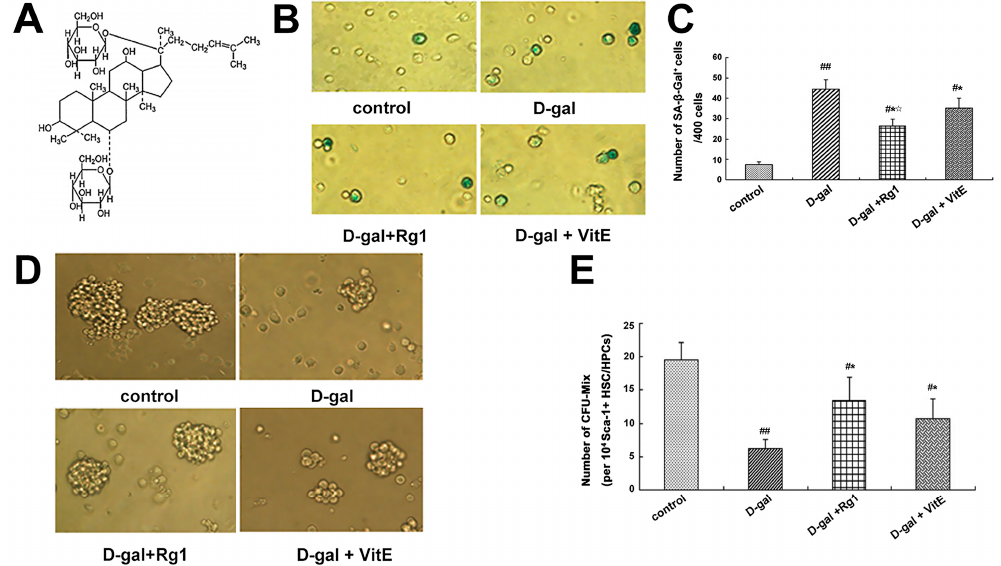
Figure 1. Effects of ginsenoside Rg1 on SA- β -Gal staining and CFU-Mix formation of Sca-1 + HSC/HPCs in a mouse model of D -gal-induced aging. ( A ) The chemical structure of ginsenoside-Rg1; ( B ) SA- β -Gal staining was performed after Sca-1 + HSC/HPCs were collected in different mouse model groups (×400). The aged cells were enlarged in shape and stained blue-green in the cytoplasm; ( C ) Quantification of SA- β -Gal–positive cells is shown. The number of SA- β -Gal–positive cells was decreased in the D -gal + Rg1 and D -gal + VitE groups compared to the D -gal model group. The total number of SA- β -Gal–positive cells was counted among 400 random cells; ( D ) CFU-Mix culture of Sca-1 + HSC/HPCs in different mouse model groups is shown (×400). In the D -gal model group, the number of CFU-Mix colonies and the number of cells that formed colonies was the lowest; ( E ) Quantification of the CFU-Mix is shown. the CFU-Mix was counted among the 1 × 10 4 cells per hole. The CFU-Mix number in the D -gal + Rg1 group was higher than in the D -gal model group (mean ± SD, n = 5; # p < 0.05, ## p < 0.01 vs. the control group, * p < 0.05 vs. the D -gal model group, ☆ p < 0.05 vs. the D -gal + VitE group).